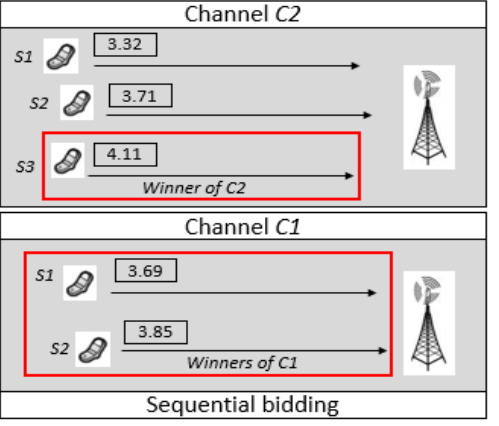
Figure 3. Sequential bidding for homogeneous